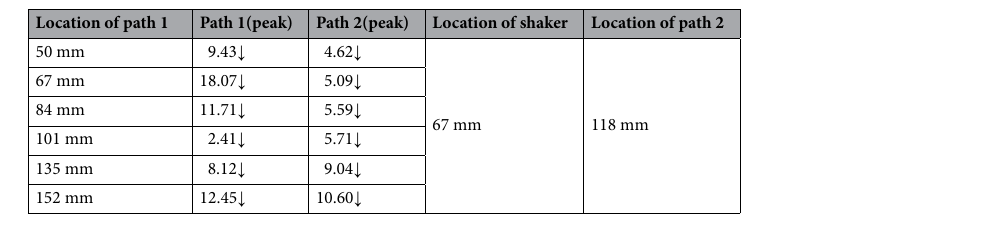
Table 3. Reduction of vibration of paths 1 and